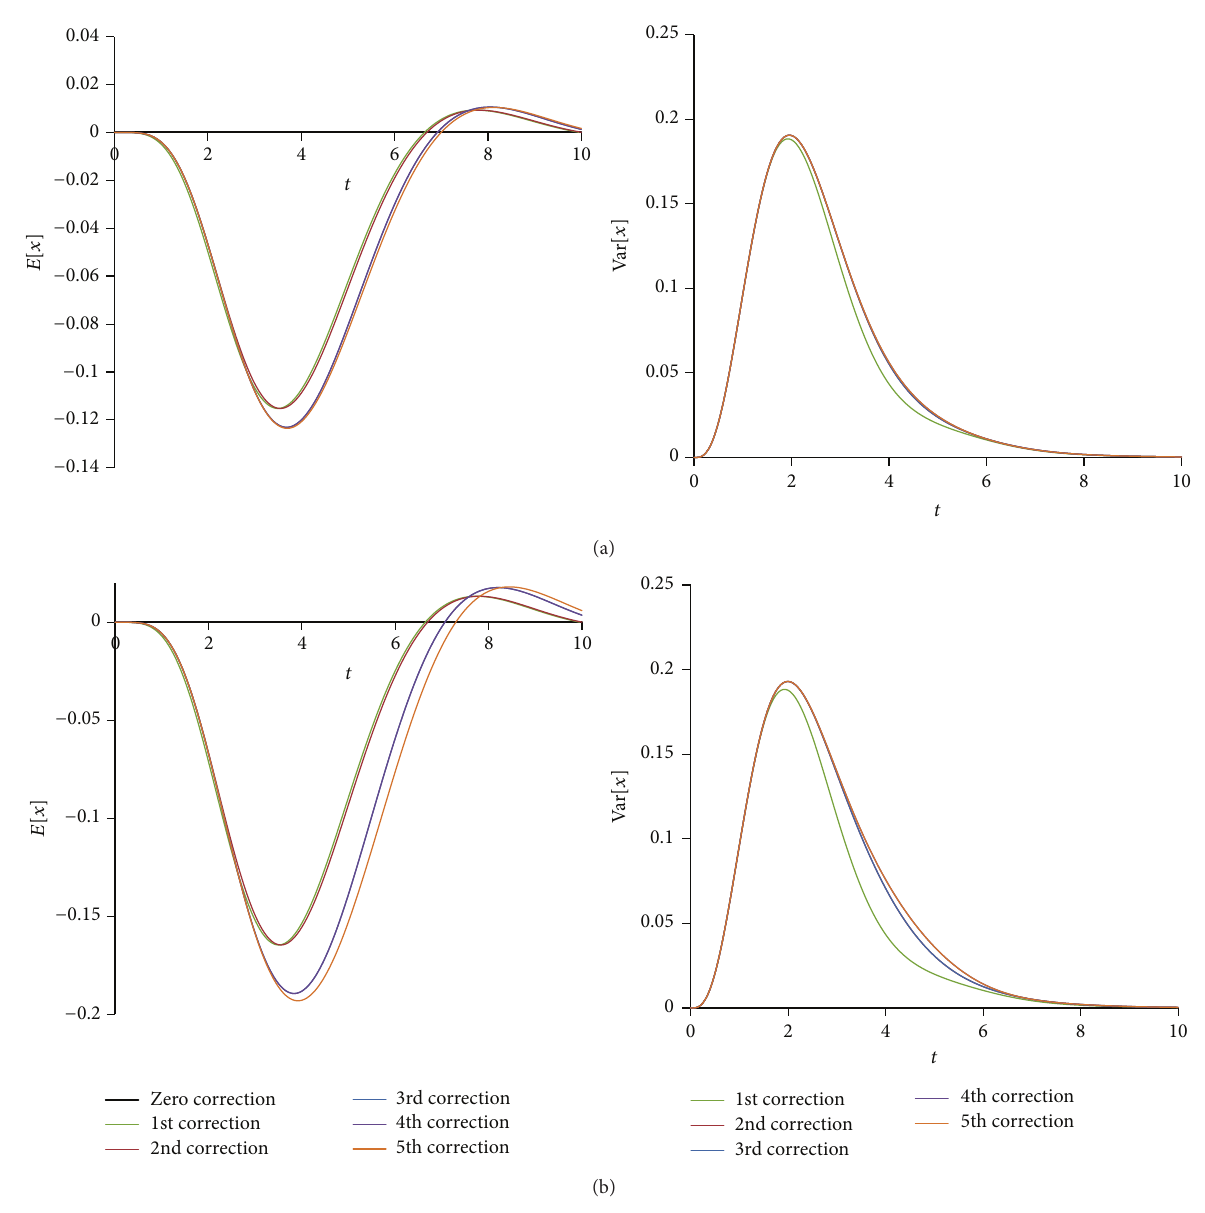
Figure 6: The first-order response mean and variance for (a) 𝜀 = 0.7 and (b) 𝜀 = 1.0 . Case of exponential function 𝑒 −0.5𝑡 multiplied by the white